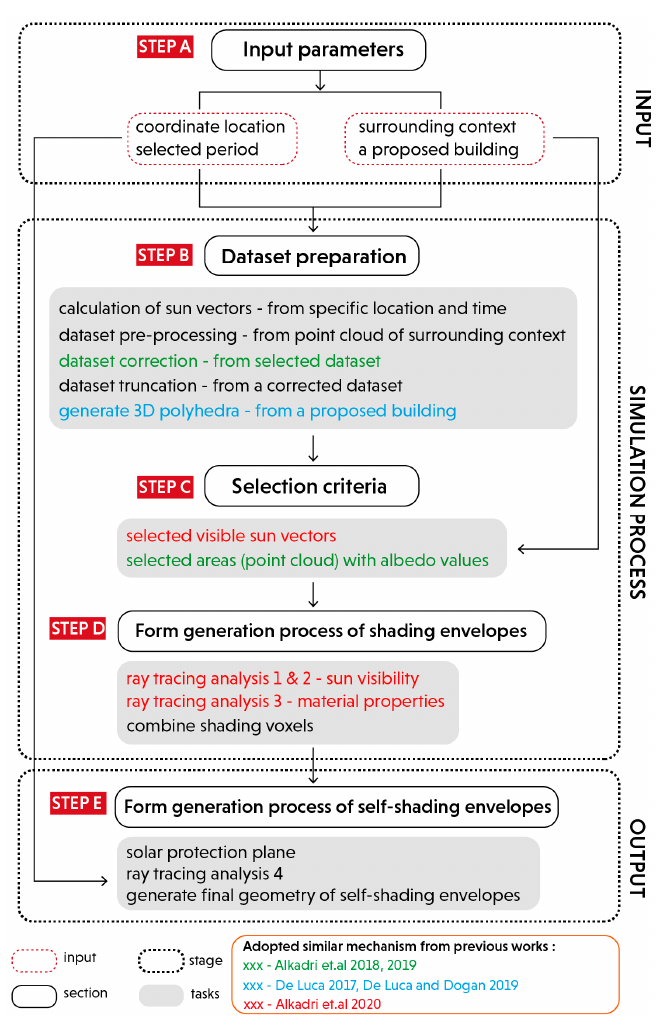
Figure 1. An overview of the proposed computational workflow.